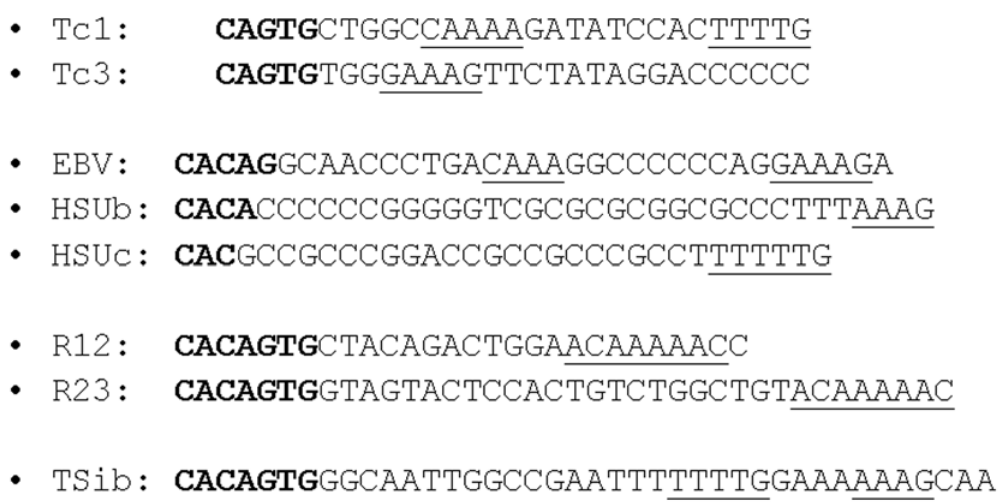
Figure 1. Mechanism of Tc element transposition, herpes recombination and V(D)J recombination suggests homologous adaptation of a primordial DDE recombinase. Recombination sites of all of these DNA elements are adjacent to a sequence containing a sequence resembling the V(D)J heptamer (bold type) and nonamer sequences (underlined). Nonamer sequences are often spaced at 12 or 23 nucleotide intervals to facilitate DNA bending. Sequences shown from top to bottom: invertebrate Tc elements Tc1, Tc3, EBV terminal repeat sequences, herpes simplex recombination sites, V(D)J RSS and transib transposon termini (Tsib) most closely related to V(D)J RSS among tranposons.